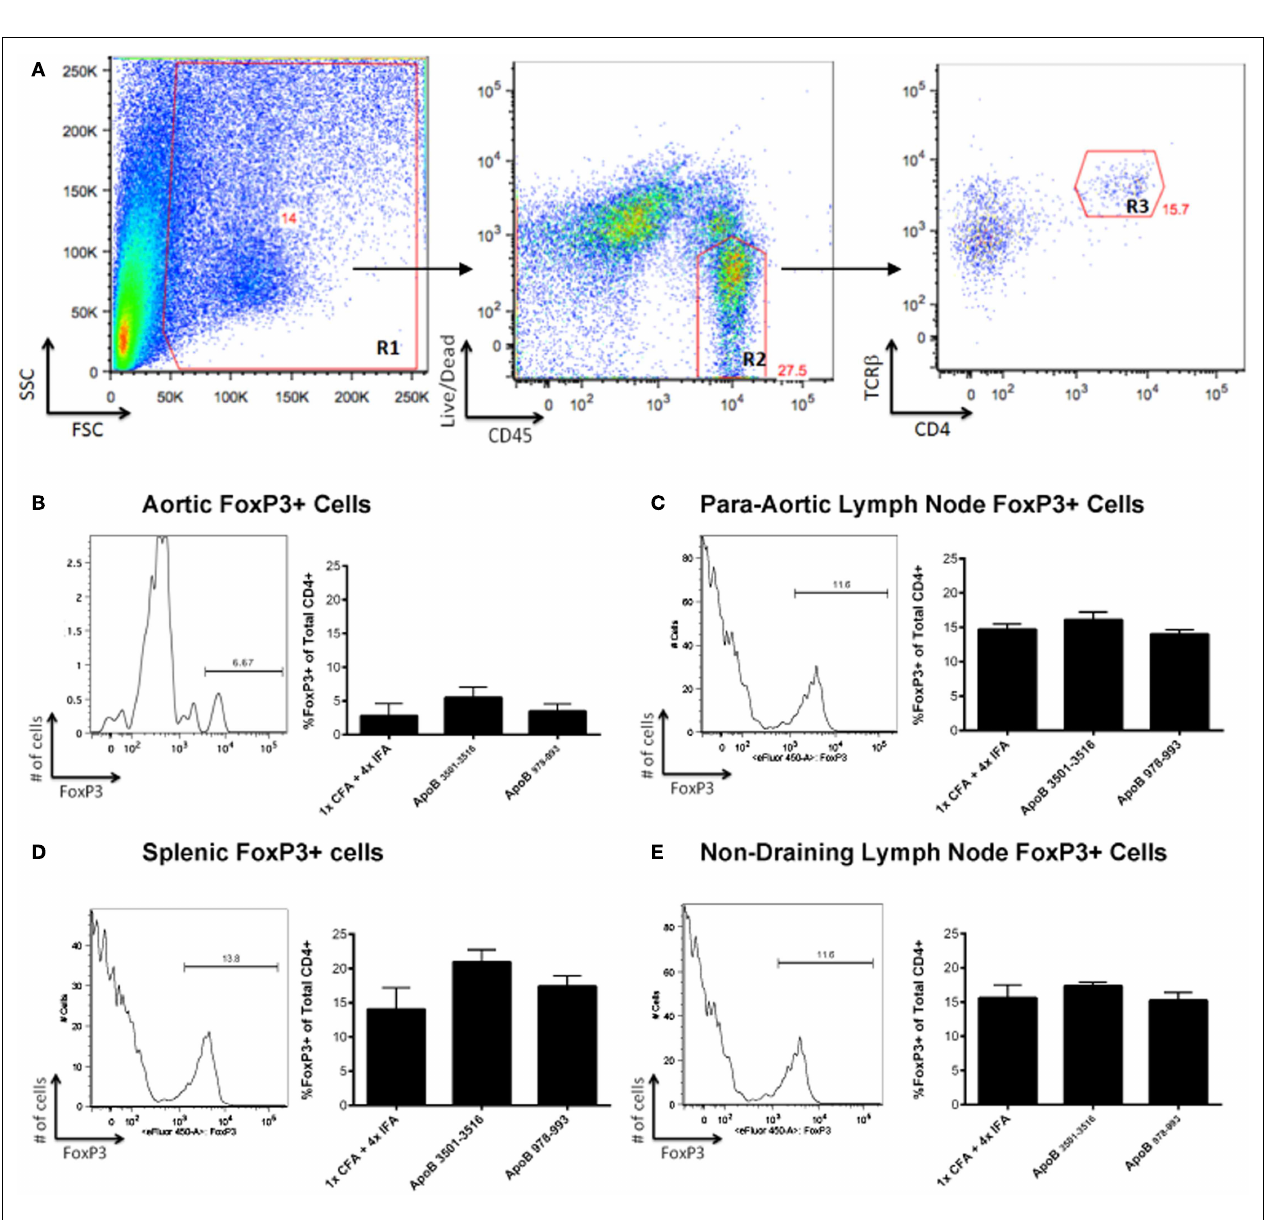
FIGURE 3 | FoxP3 + T-cells are not found in increased numbers in ApoB 3501–3516 orApoB 978–993 immunized mice . (A) The lymphocyte population was captured via forward scatter (FSC) and side scatter (SSC) gating as shown in Region 1 (R1). Live CD45 + cells were isolated (R2), of whichTCR β + /CD4 + cells were selected (R3) and examined for their expression of FoxP3 + . Analysis of a representative aorta is shown.